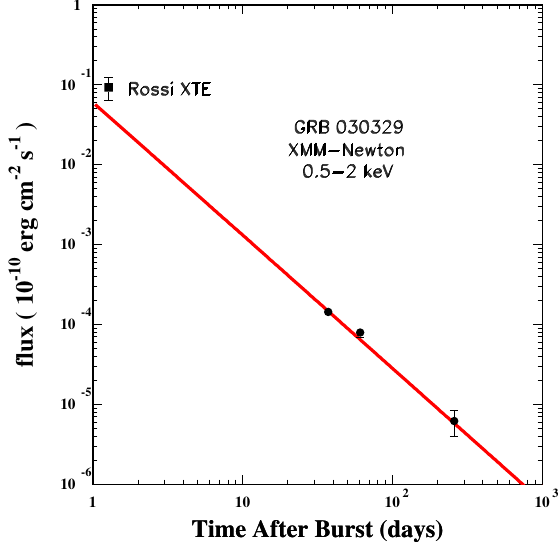
Figure 25. The late-time 0.5-2 keV X-ray AG of the joint source GRB030329/SN2003dh as measured by Rossi-XTE and XMM-Newton [177]. The line is the CB model expectation (for the predicted α x = β x + 1/2 ) and, in this case, β x = 1.17 ± 0.04.